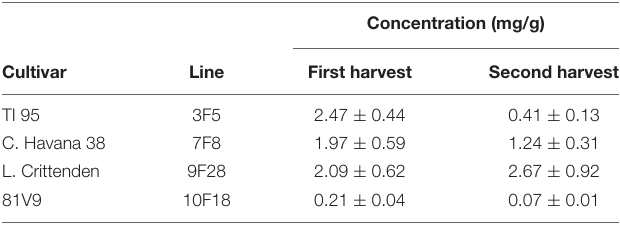
TABLE 2 | The concentration of PFA (g/kg fresh tobacco leaf) from the field trial.